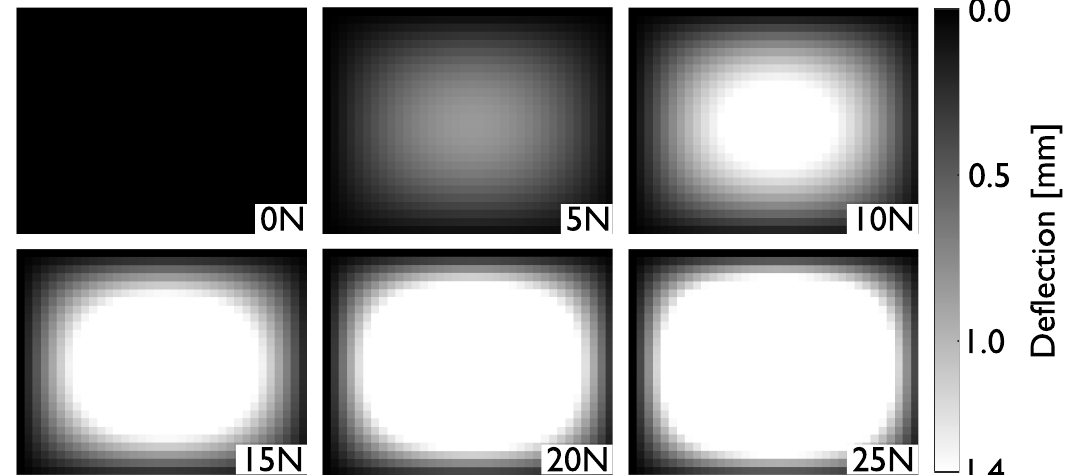
Figure 3. Finite element analysis of the pressure sensor for typical loads inside the interface. Note the stagnating deflection for loads above 10